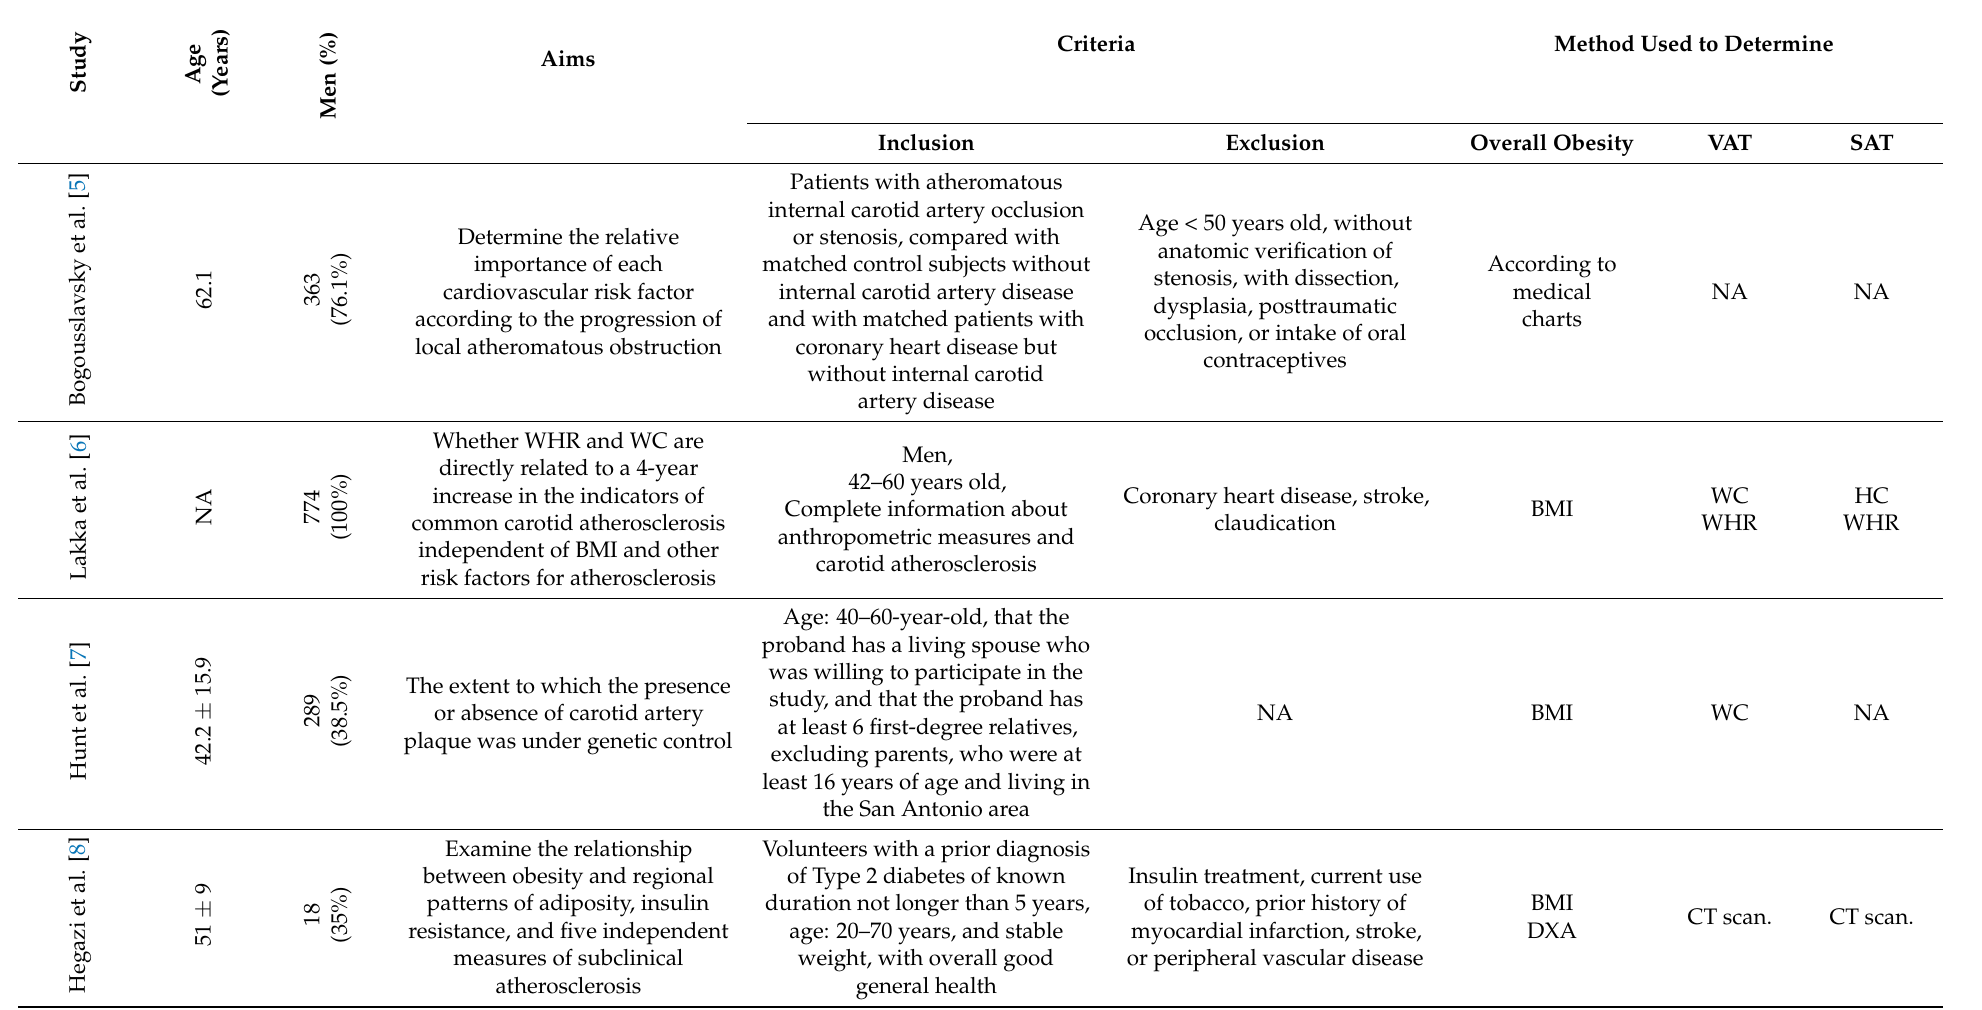
Table 2. Study aims, inclusion and exclusion criteria, methods to study adipose